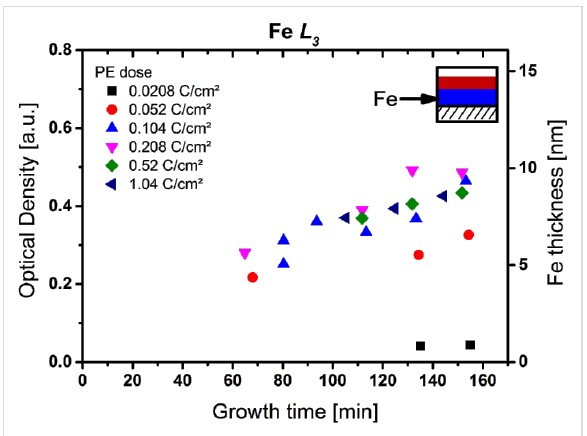
Figure 6: Optical density at the Fe L 3 edge at 708.7 eV (left vertical axis) and average thickness of the iron layer (right vertical axis) of various CoO x N y C z /Fe nanostructures versus autocatalytic growth time for Fe(CO) 5 . The different symbols indicate different primary electron (PE) doses. Above 0.05 C/cm 2 , the thickness/optical density increases linearly with the growth time at a rate of 0.5 ± 0.1 Å/min irrespective of the applied PE dose. Lower PE doses (red, black) exhibit reduced thickness.